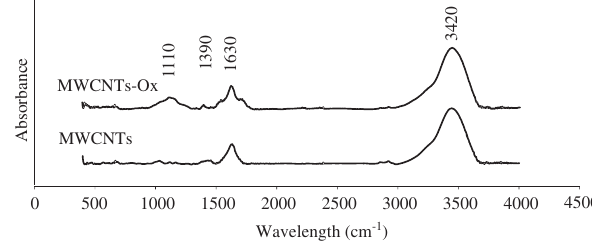
Figure 1: Fourier-transform infrared (FT-IR) spectra of carbon nanotubes